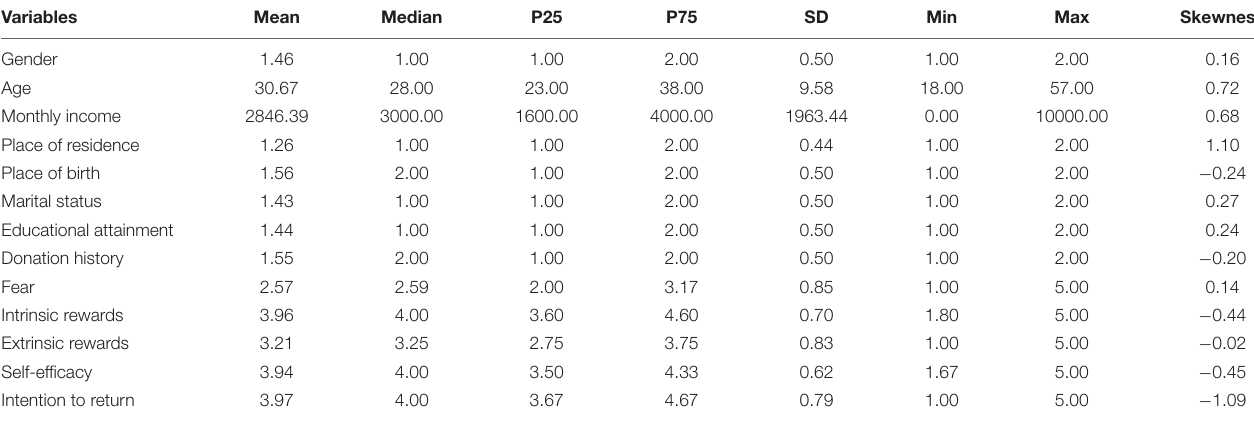
TABLE 1 | Population statistics of all included